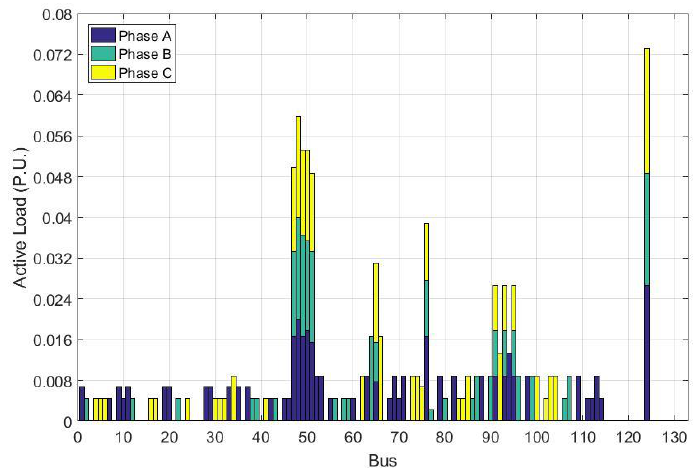
Figure 3. IEEE 123-Bus System Load (adapted).